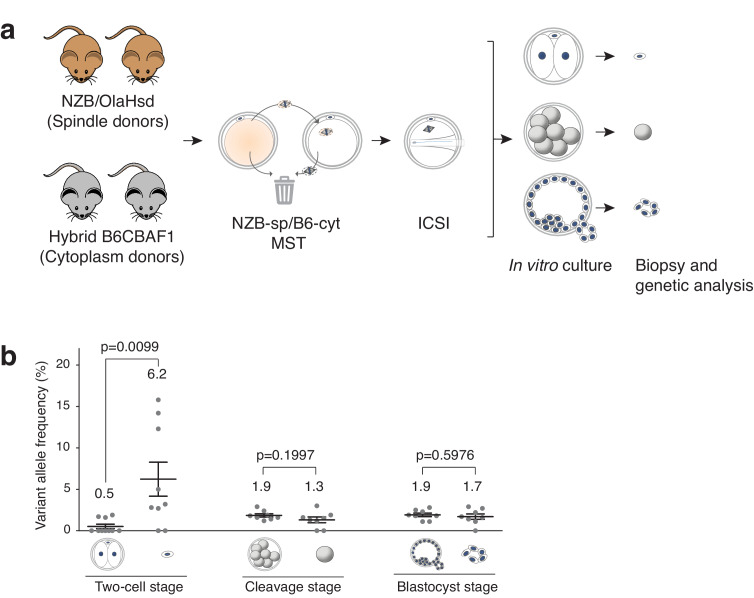
Analysis of mtDNA carryover in biopsied cells and complementary embryos from MST between NZB/OlaHsd and B6CBAF1 strain oocytes.(a) Schematic representation of the experimental design. (b) Variant allele frequencies detected in embryo specimens. Dots represent allele frequencies of individual samples. Unpaired t-test was used to compare frequencies between biopsies and corresponding entire embryos. ns = not significant. See also Figure 3—figure supplements 1–2.